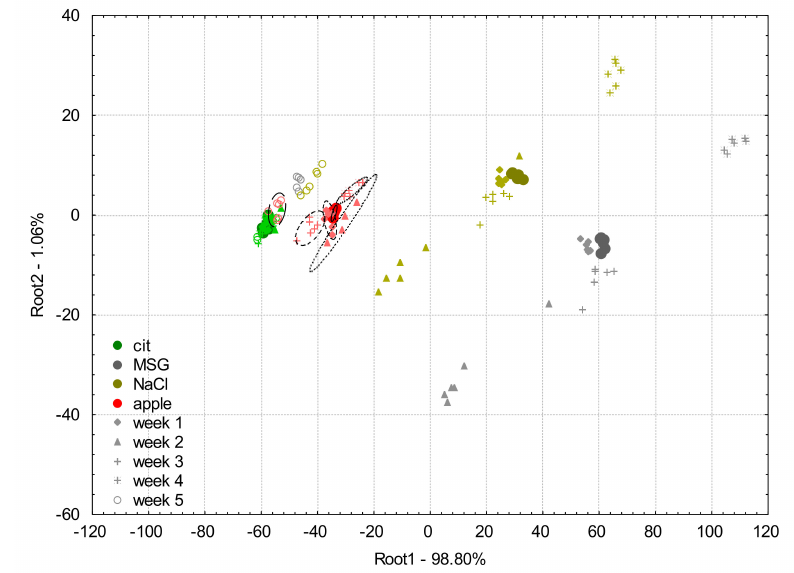
Figure 10. Linear discriminant analysis plots for the drift corrected dataset using the modified component correction method of the e-tongue measurements of apple juice samples (red symbols) and model solutions: citric acid (green symbols), NaCl (gold symbols), and MSG (gray symbols). The correction was performed based on pairing each week to week 0. The solid circles indicate the measurements on week 0 which was used to build the linear discriminant analysis model, and the di ff erent symbols (diamond, triangle, plus, asterisk, and circle) stand for the di ff erent weeks 1–5,